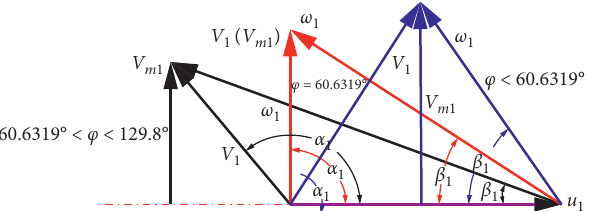
Figure 24: Inlet speed triangle under different inlet setting angles.